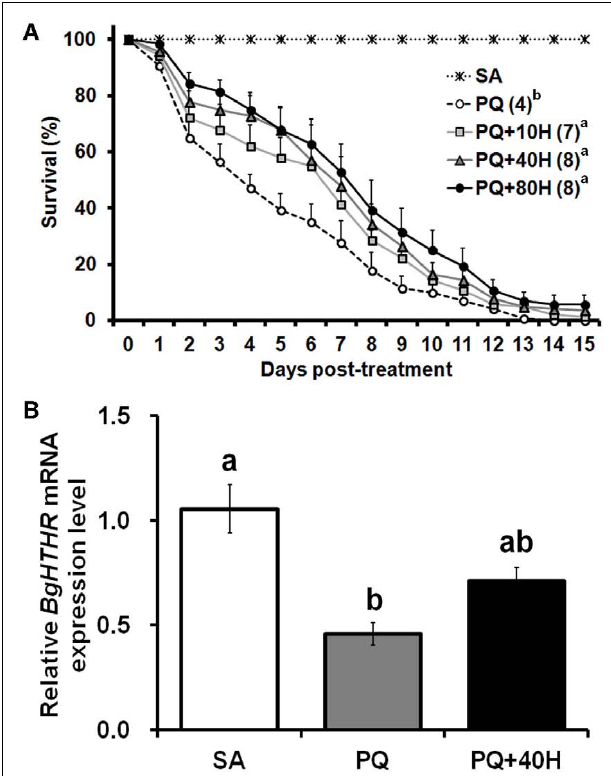
FIGURE 4 | (A) Survival curve of male adults of Blattella germanica after treatment with paraquat (PQ) and HTH (H). SA, injection with saline (control); PQ, injection with 1 μ l of 20mM PQ; 10H, 40H, and 80H, injection with various concentrations (pmol) of HTH.The median survival time (days) is indicated in the parenthesis of each treatment group. (B) Quantitative real-time PCR analyses on mRNA expression of Blage-HTHR in fat body of adult male of B. germanica 4h after the treatment. Expression levels were calculated after normalizing against BgActin expression in each sample. Results are indicated as the mean ± SEM ( n = 3 per treatment